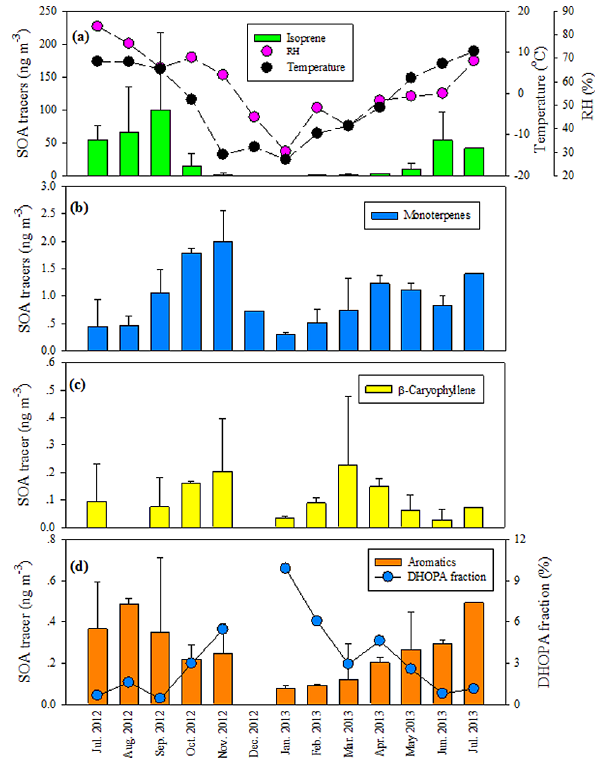
Figure 2. Monthly variations of SOA tracers.